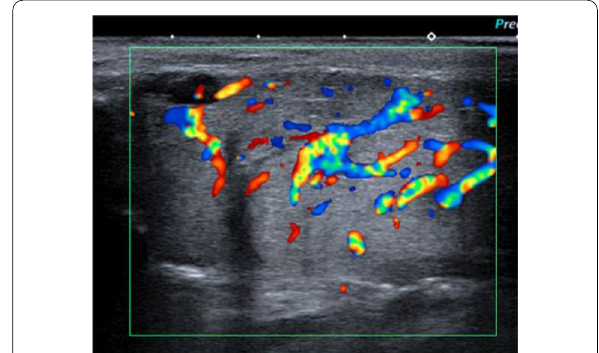
Fig. 3 Acute viral right parotitis. Enlarged, hypervascularized parotid on